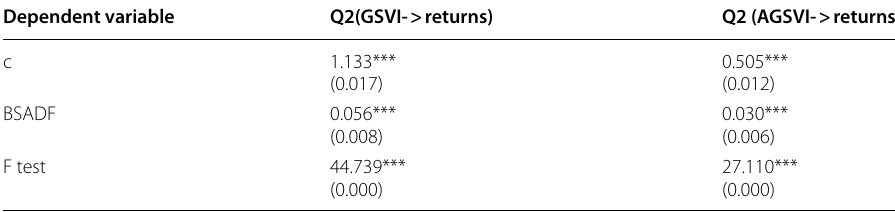
Table 4 Estimated model of TV-GC and bubble test statistics